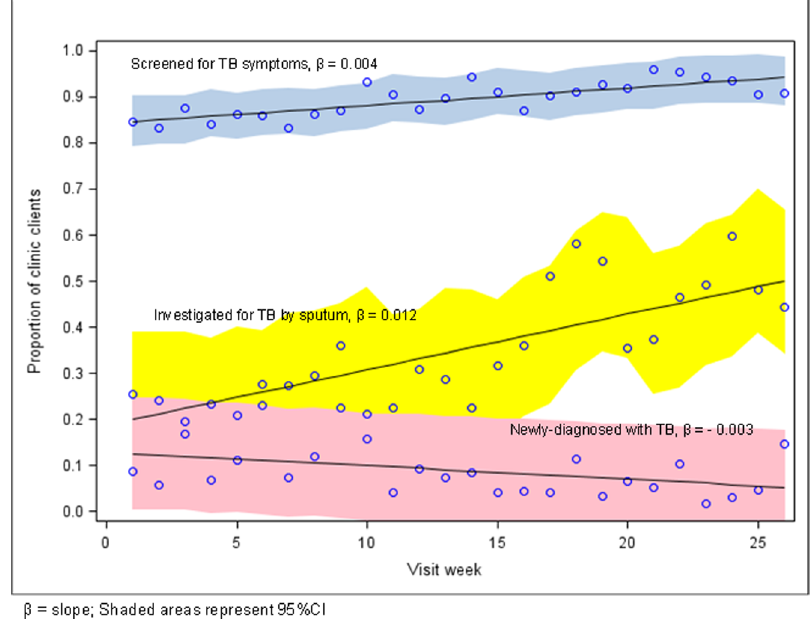
Figure 3. Systematic TB symptom screening and assessment at primary care clinic in Johannesburg, South Africa: coverage, case detection, and sustainability over a 26-week period.